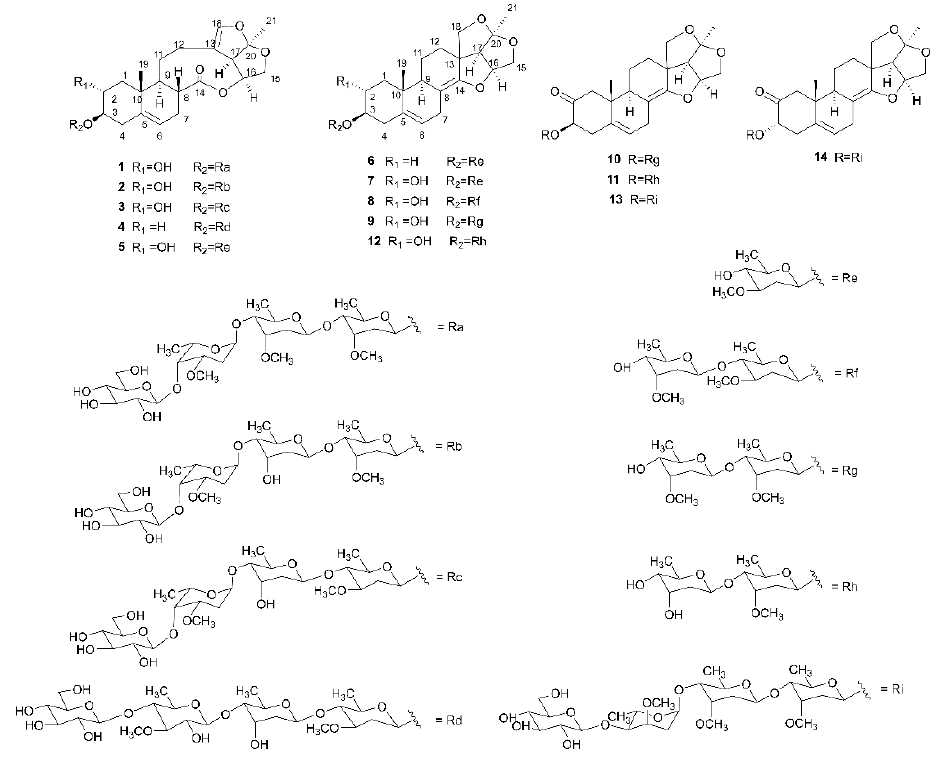
Figure 1. Structures of compounds 1 – 14 .